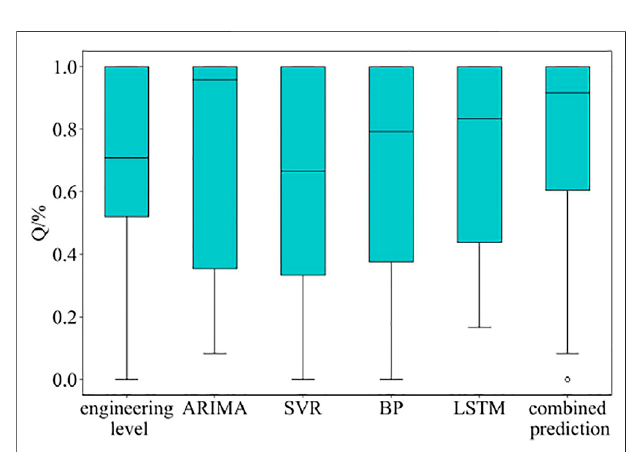
FIGURE 11 | Q box diagram of each